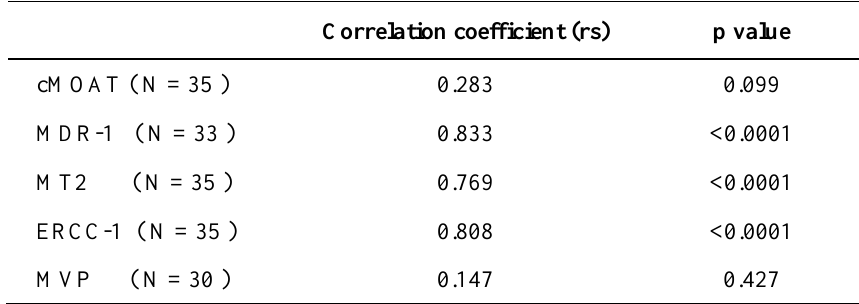
Table 4. Correlation of the mRNA expression of each resistant factor gene between T and